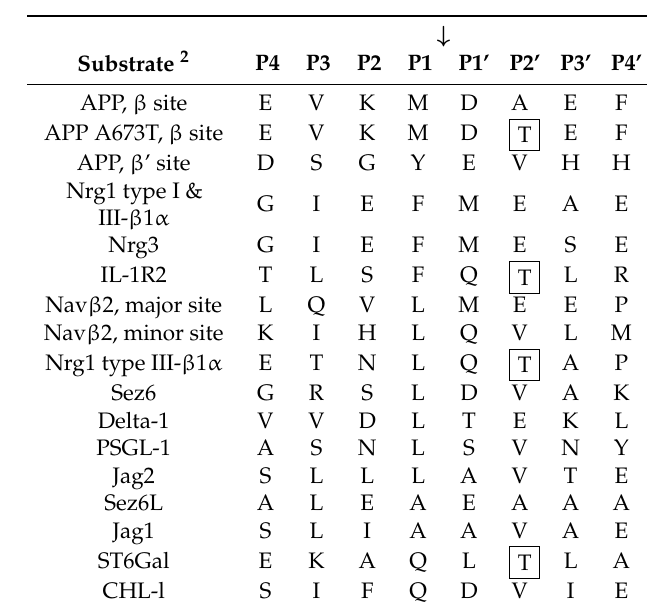
Table 2. BACE1 substrate amino acid sequences in the proximity of the BACE1 cleavage site 1